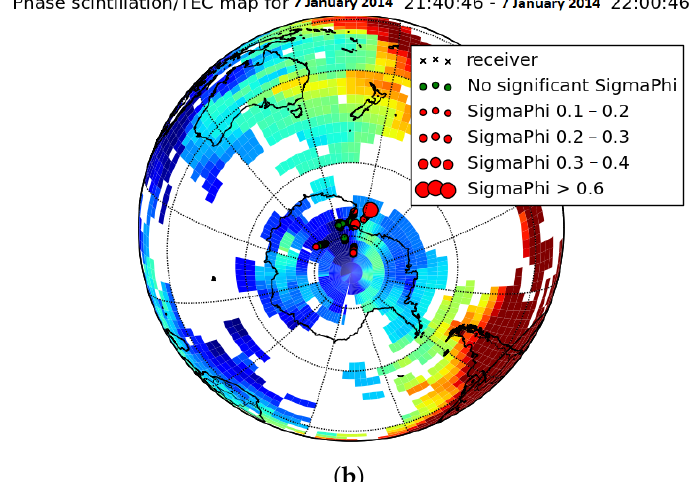
Figure 3. An example GPS scintillation event observed at the Antarctic McMurdo scintillation Station from MIT Madrigal. Adapted from [27] ( a ) S4 measurement; ( b ) SigmaPhi ( σ φ ) measurement.